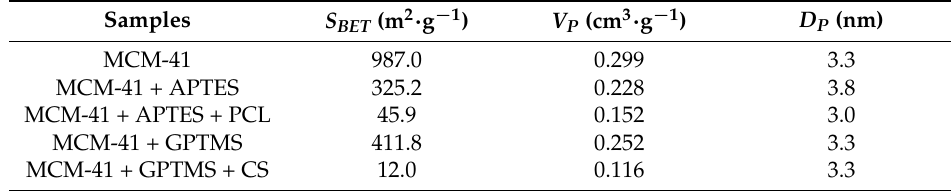
Table 2. N 2 adsorption/desorption analysis of pure MCM-41 and modified samples. Samples